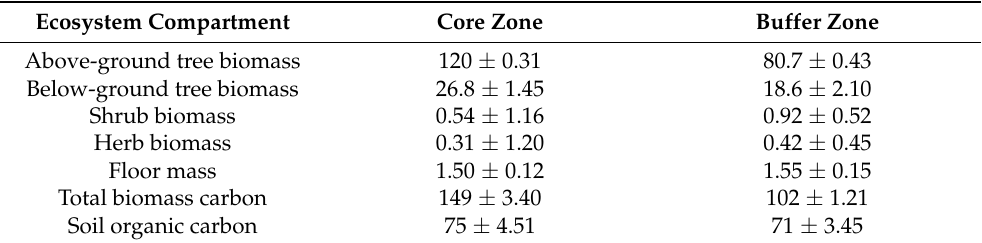
Table 4. Distribution of carbon stocks (Mg C ha − 1 ) (mean ± standard error) in different ecosystem compartments of core and buffer zone of Minkong Community Forest Reserve, Nagaland, India.